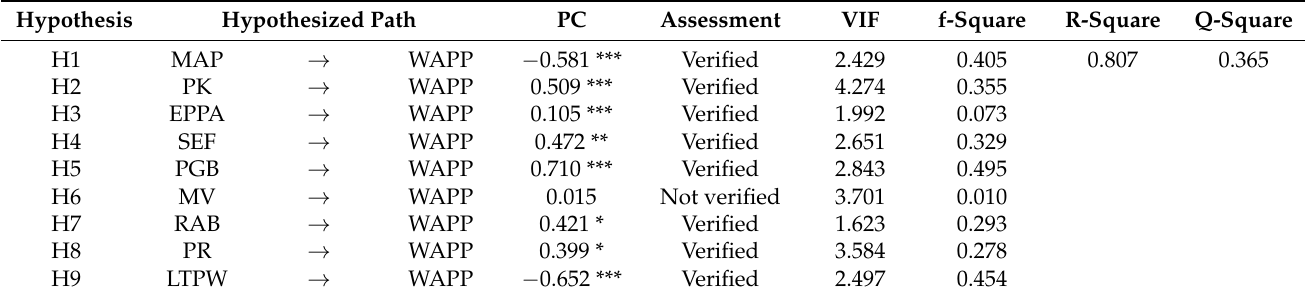
Table 5. Path modeling analysis and post-estimation criteria results.